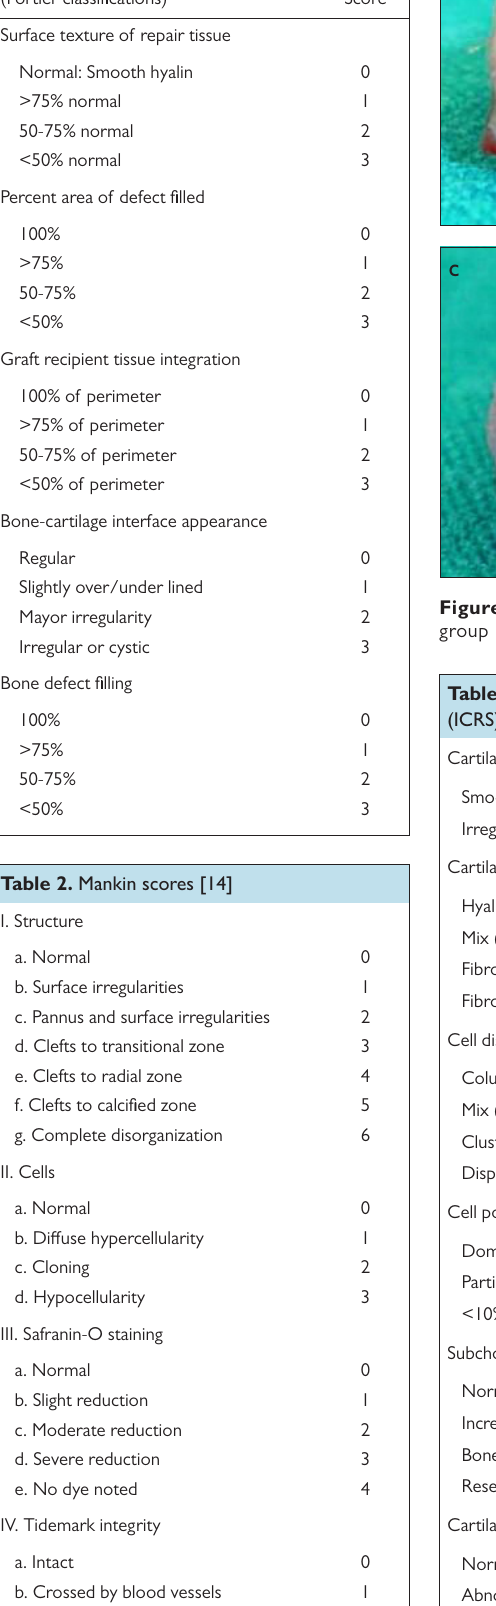
Table 1. Macroscopic modified Fortier classifi- cations [13] Scoring system used for gross appearance (Fortier classifications)